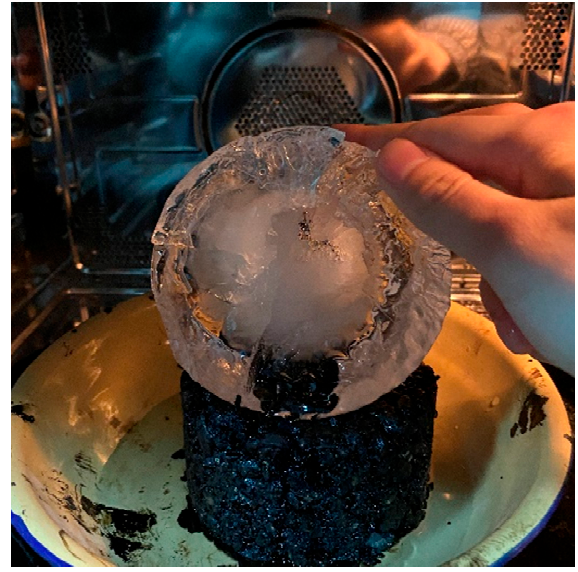
Figure 18. Inverted bowl-shaped ice layer after microwave